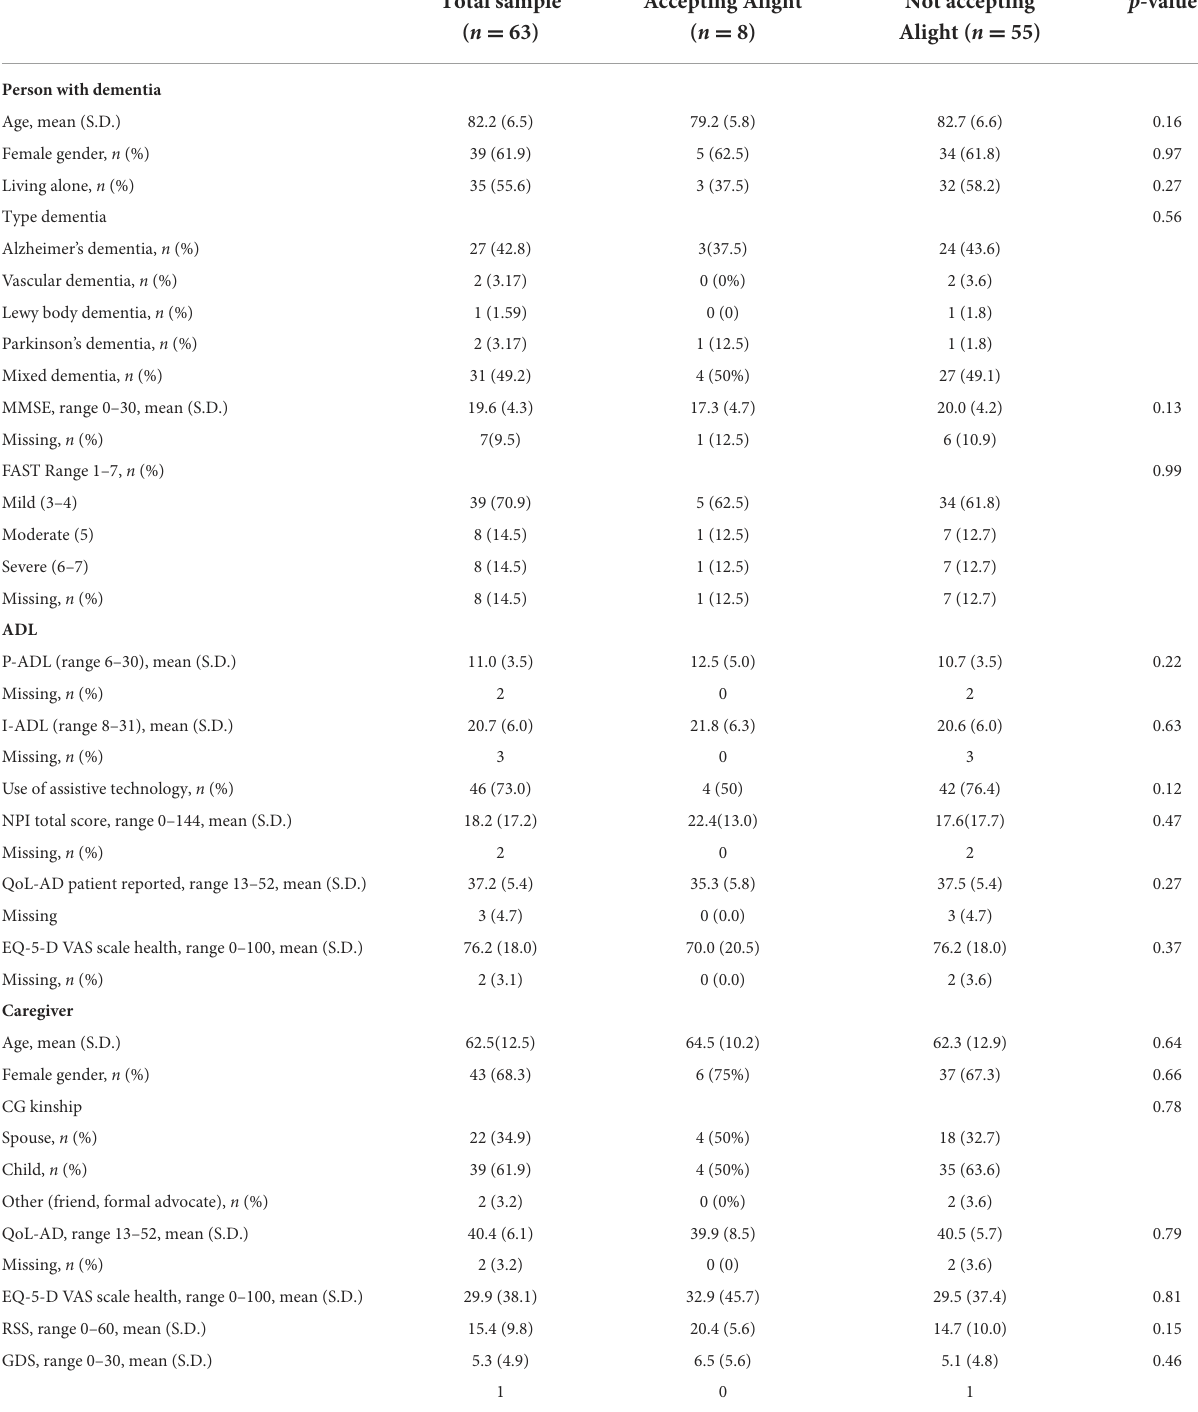
TABLE 1 Characteristics of the sample offered Alight application in the LIVE@Home.Path